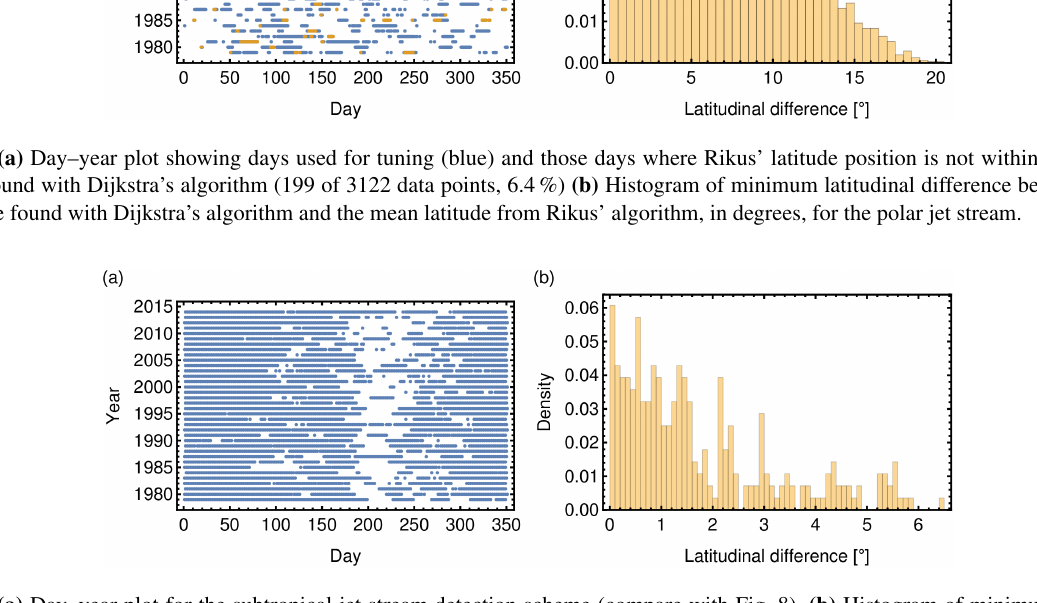
Figure 9. (a) Day–year plot for the subtropical jet stream detection scheme (compare with Fig. 8). (b) Histogram of minimum latitudinal difference between the jet stream core found with Dijkstra’s algorithm and the mean latitude from Rikus’ algorithm, in degrees, for the subtropical jet